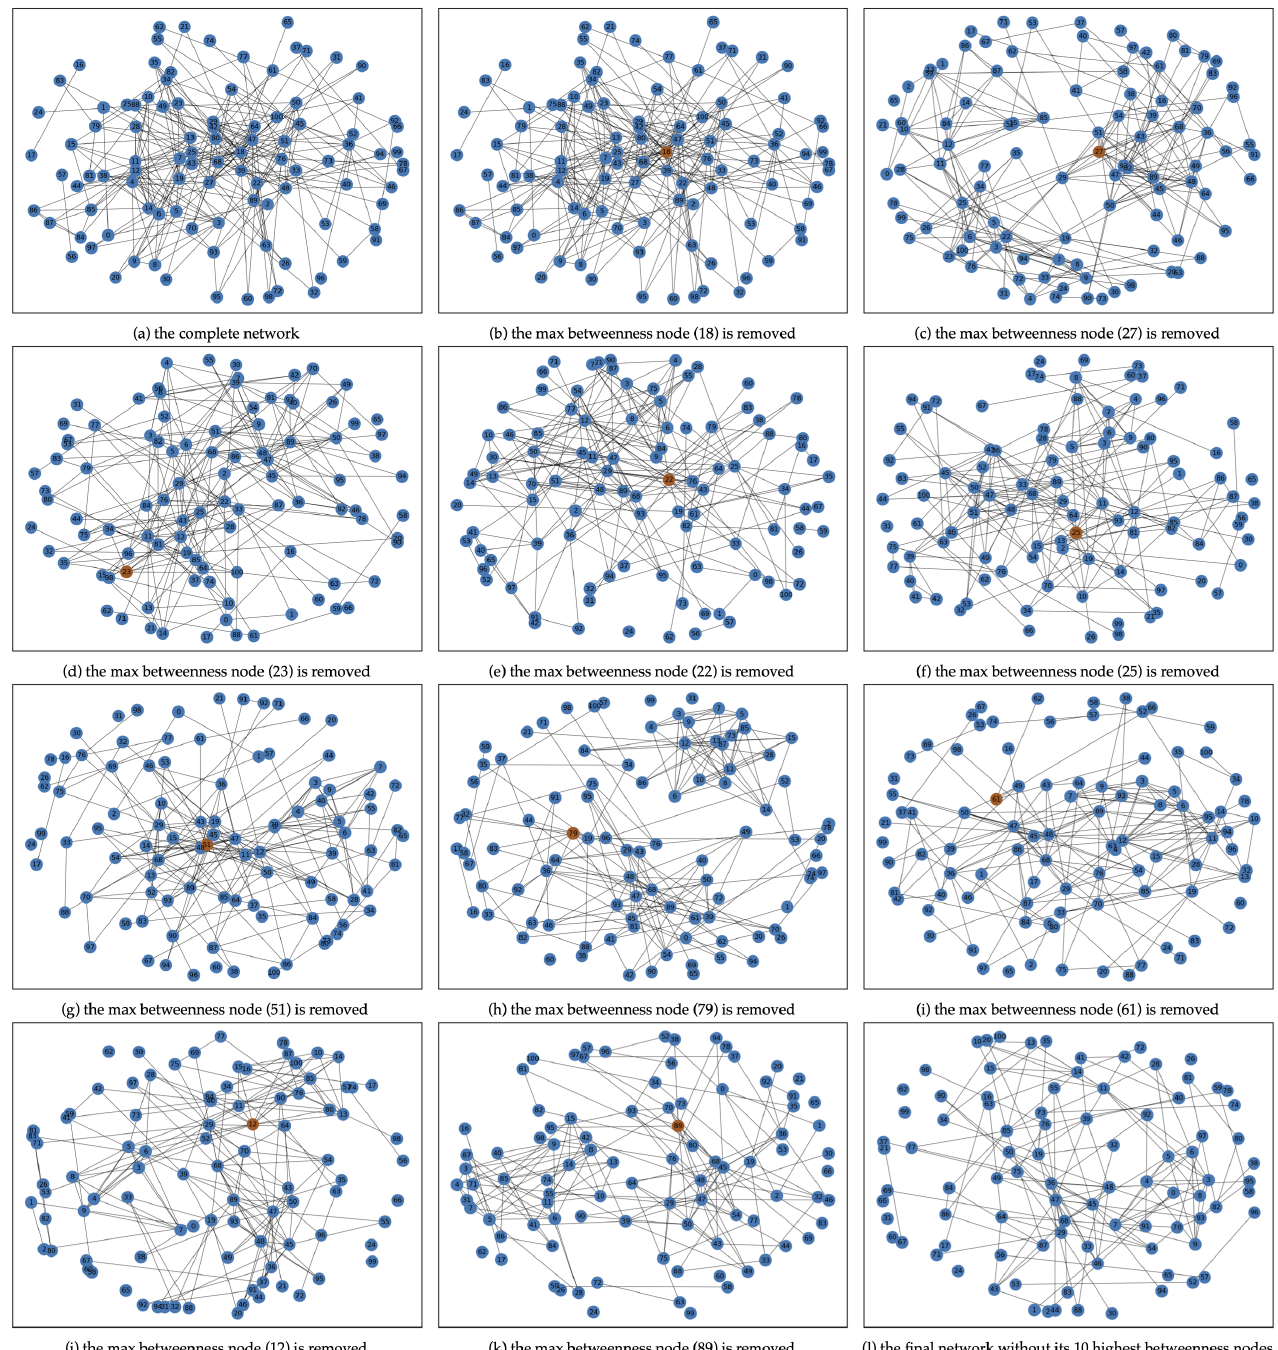
Figure 5. Removal of the 10 most important nodes according to betweenness centrality in the Meetings network extracted from the Sicilian Mafia operation called Montagna [26]. The first picture ( a ) shows the complete network. Then, at each step ( b – k ), the node with the highest value of betweenness centrality is marked in brown, then removed. The last picture ( l ) shows the network without its 10 most central